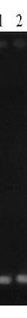
Fig. 4. Electrophoretogram of the PCR products: PCR product amplified (207-bp) from sperm total DNA for showing mutation existence in exon7, Nsun7 gene. Line 8, normospermic; Line 1, 2, 3, 4, 5, 6, and